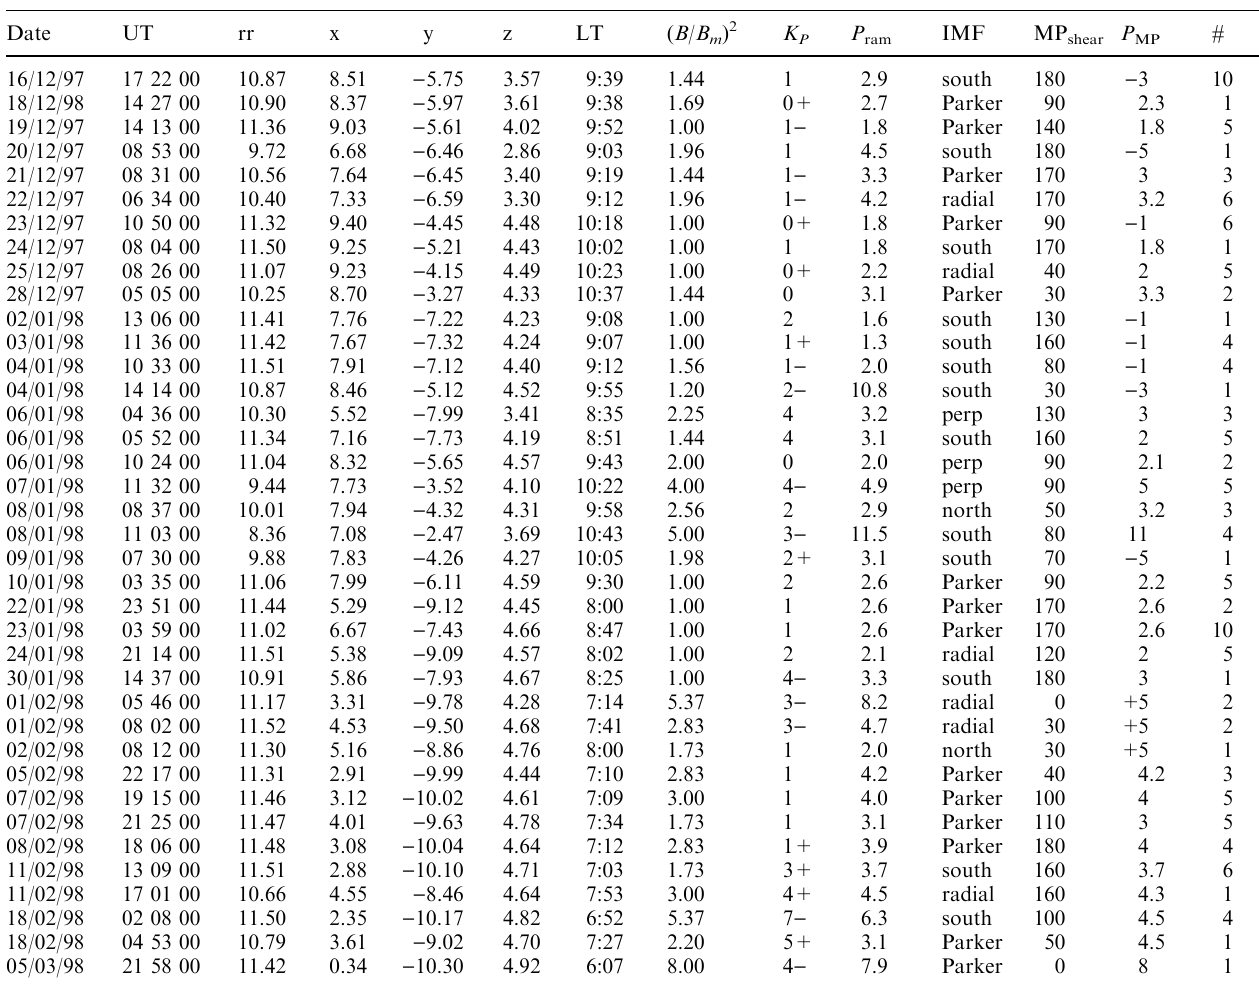
Table 1. Properties of main magnetopause